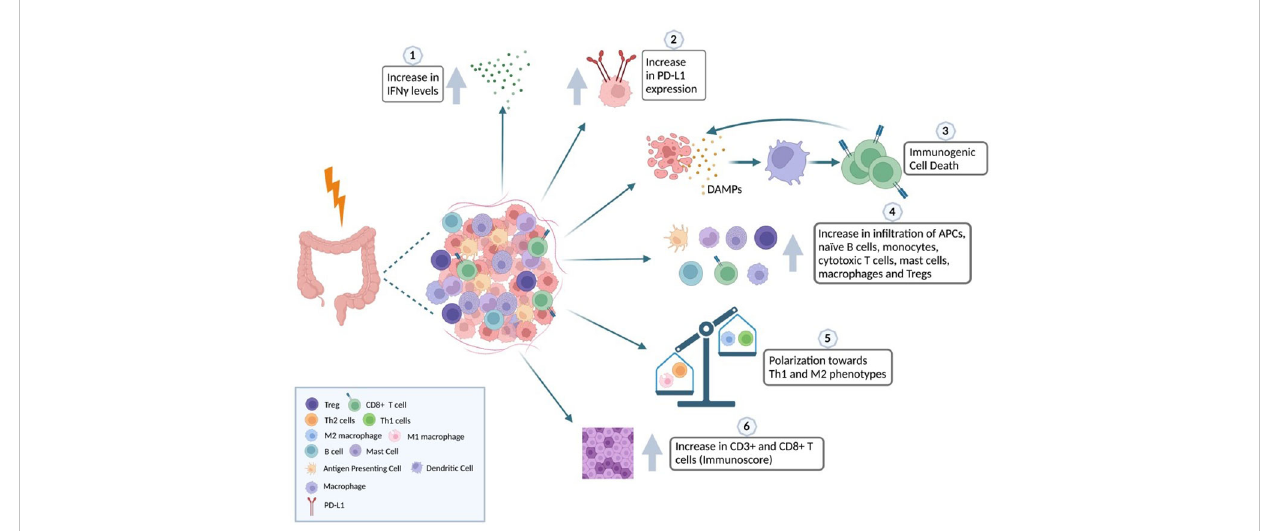
FIGURE 2 Impact of radiation in the iTME of colorectal cancer. The relationship between radiotherapy and the immune landscape of CRC is complex and context-dependent. Radiotherapy has the potential to harm normal tissues and stimulate the secretion of in fl ammatory cytokines like IFN g (1).